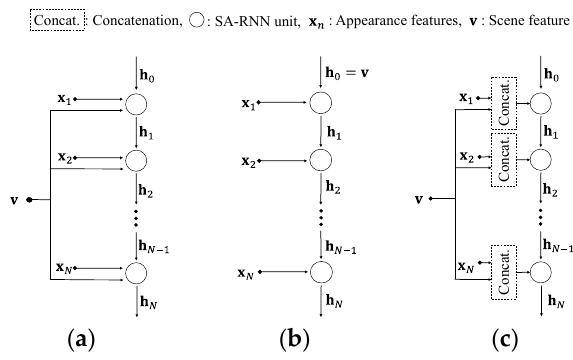
Figure 5. Three types of visual scene-aware LSTM. ( a ) Type A, ( b ) Type B, ( c ) Type C.